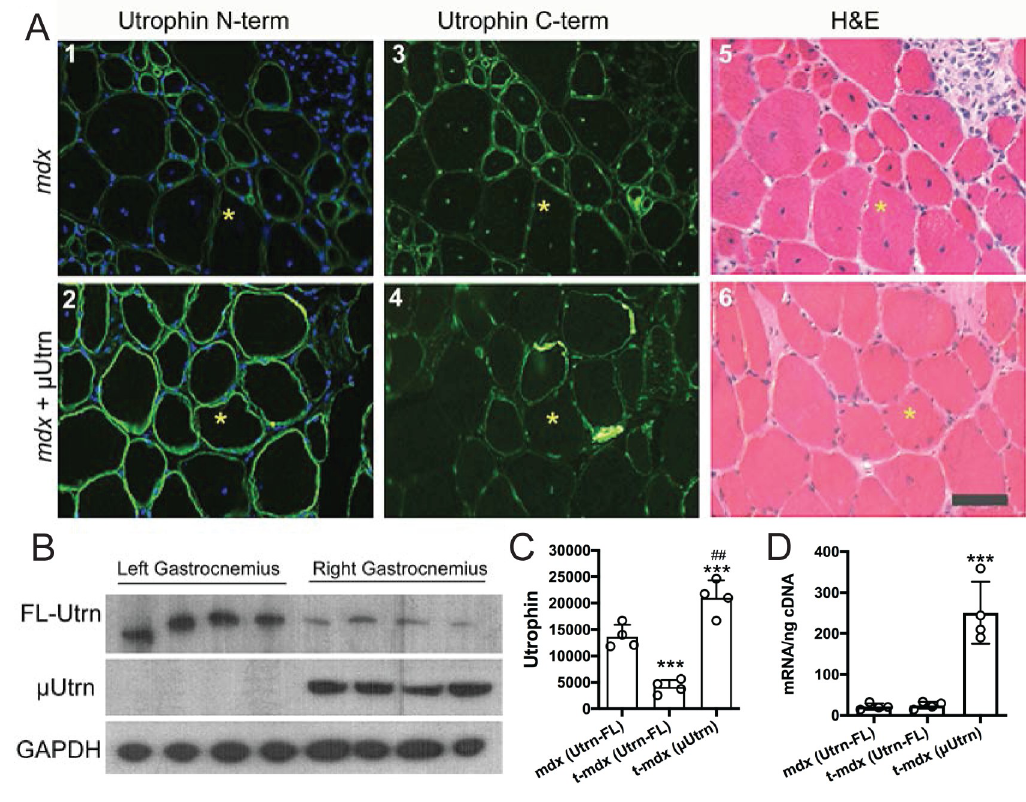
Fig 2. μ Utrn expression mitigates dystrophic pathology. (A.) Adjacent sections of mdx 4cv muscles and mdx 4cv muscles directly injected with rAAV6-CK8- μ Utrn. Scale bar = 50 μ m. (B.) Western blot showing full length utrophin and μ Utrn in untreated (left) and treated (right) gastrocnemius muscles (n = 4). GAPDH is the loading control. (C.) Quantitation of utrophin signal intensity from the Western blots. ��� P < 0.001 compared to utrophin full-length in the treated muscles. (D.) Quantitation of full length utrophin and micro-utrophin mRNA by qRT-PCR. ��� P < 0.001 compared to utrophin full-length in treated and untreated